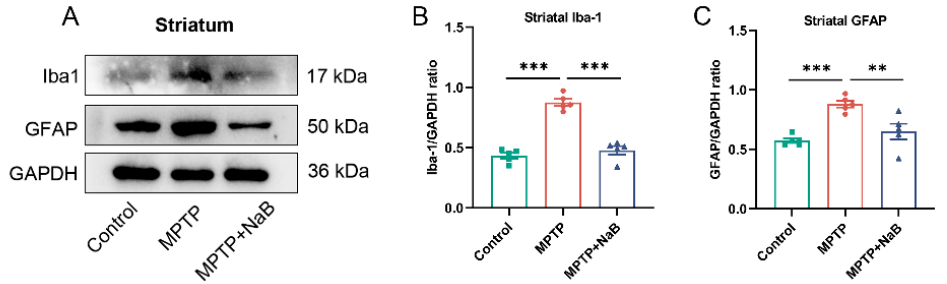
Figure 4. Sodium butyrate (NaB) inhibits the activation of microglia and astrocytes in 1-methyl-4- phenyl-1,2,3,6-tetrahydropyridine (MPTP)-induced Parkinson’s disease (PD) mice. ( A ) Representa- tive Western blot for Iba-1 and GFAP expression in the striatum. ( B , C ) The density analysis for Iba- 1 and GFAP bands in the striatum. Band intensities were normalized to GAPDH for quantification. n = 5 mice per group; ** p < 0.01, *** p < 0.01; data are presented as means ± SEM.